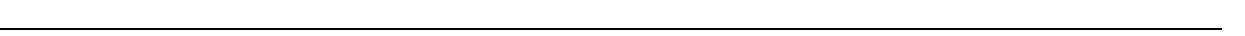
Fig. 2 Bimolecular fl uorescent complementation (BiFC) PAR biosensors detect cellular PARylation. a BiFC PAR biosensor-PBZ coding sequence was fused to the N-terminus of Venus (VN) (PBZ-VN); the C-terminus of Venus (VC) was fused to query protein (protein-VC). PARylation of the query protein leads to VC – VN interaction and restoration of a fl uorescent GFP. b HeLa cells were transfected with constructs expressing: VN + VC, PBZ-VN, PBZ-VC, PBZ-VN